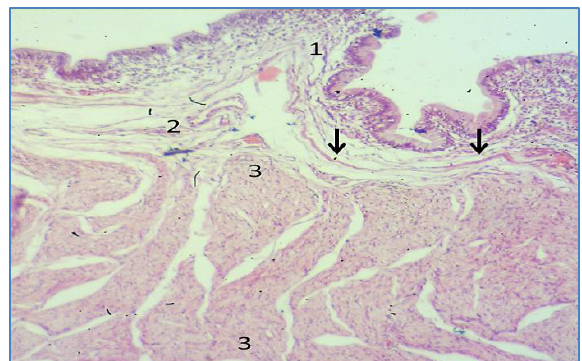
Figure, 7: urodeum wall (hen turkey) shows: mucosal villus (1), tunica submucosa (2) inner circular smooth muscle fibers (3), and muscularis mucosa (arrows) (H and E) satin. 100x.